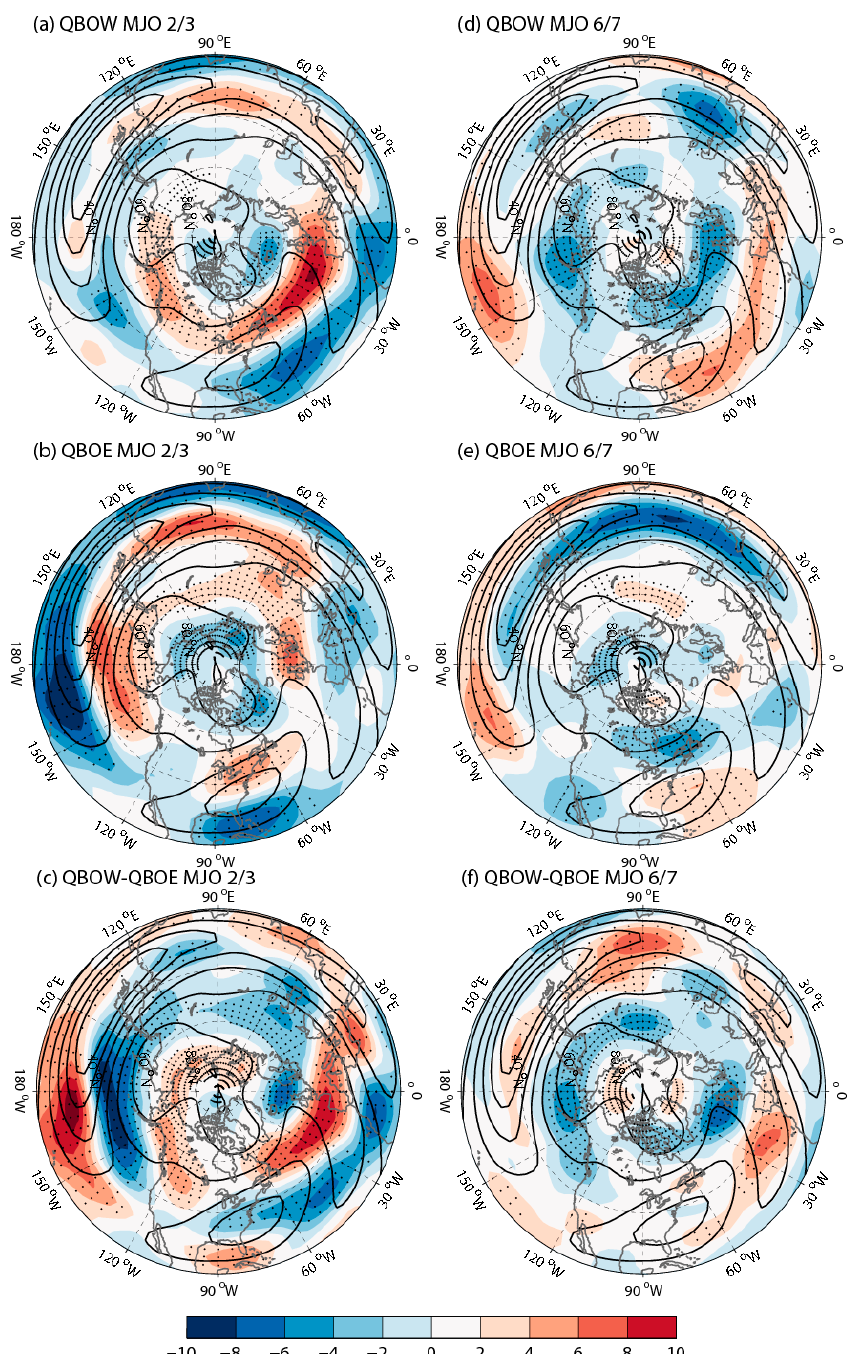
Figure 5. Composite zonal wind anomalies at 200 hPa (shading, m/s) averaged from 10 to 14 days after the MJO phase 2/3 in QBOW ( a ), QBOE ( b ) years, and the difference between the QBOW and QBOE years ( c ). Subplots ( d )–( f ) are the same as ( a )–( c ) but for the MJO phase 6/7. The black contours denote the climatological zonal wind in winter. The black dots indicate anomalies significant at the 95% confidence level by Student’s t test.